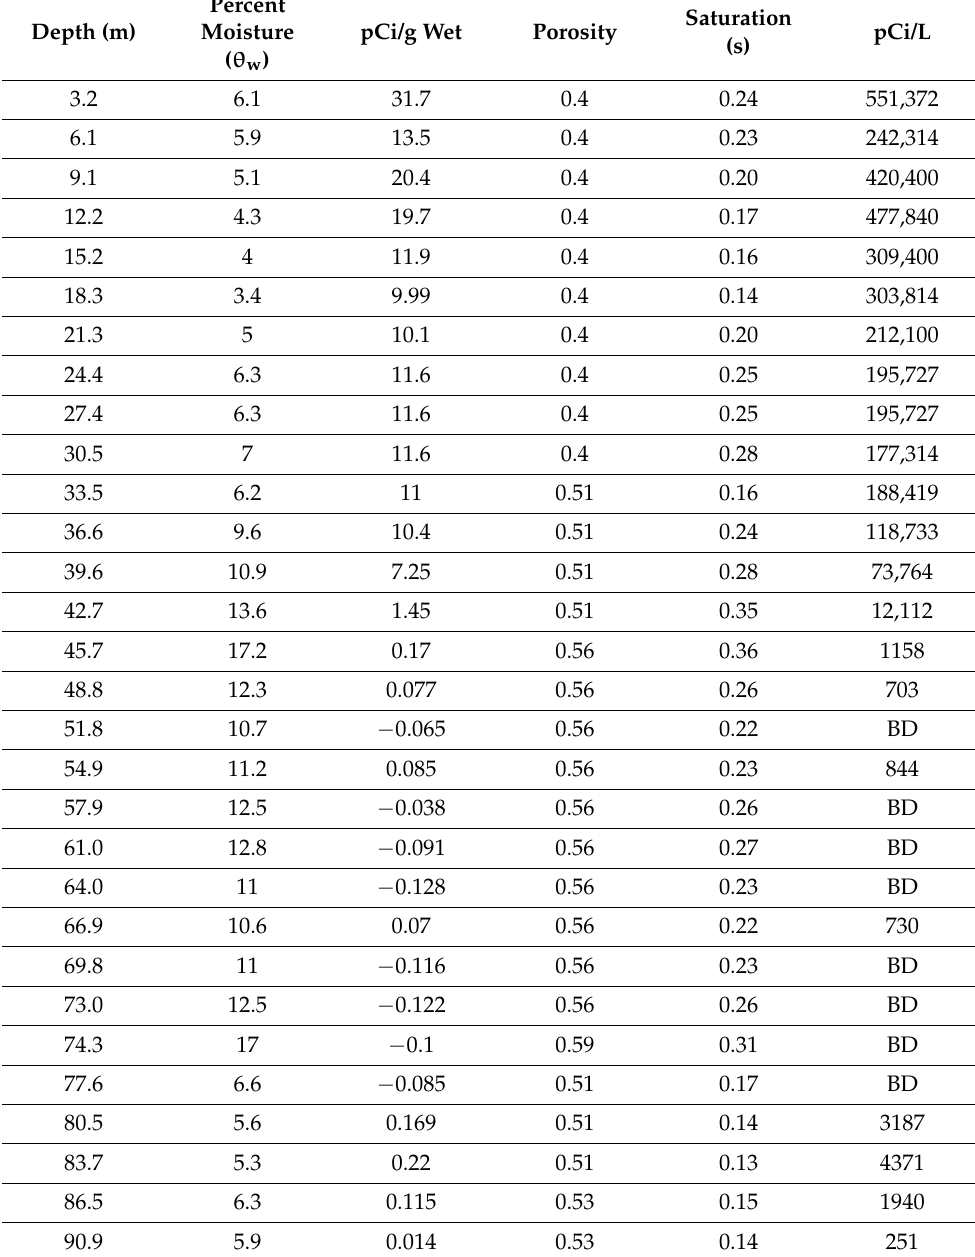
Table 2. Borehole 7 moisture content, saturation, porosity and tritium concentration